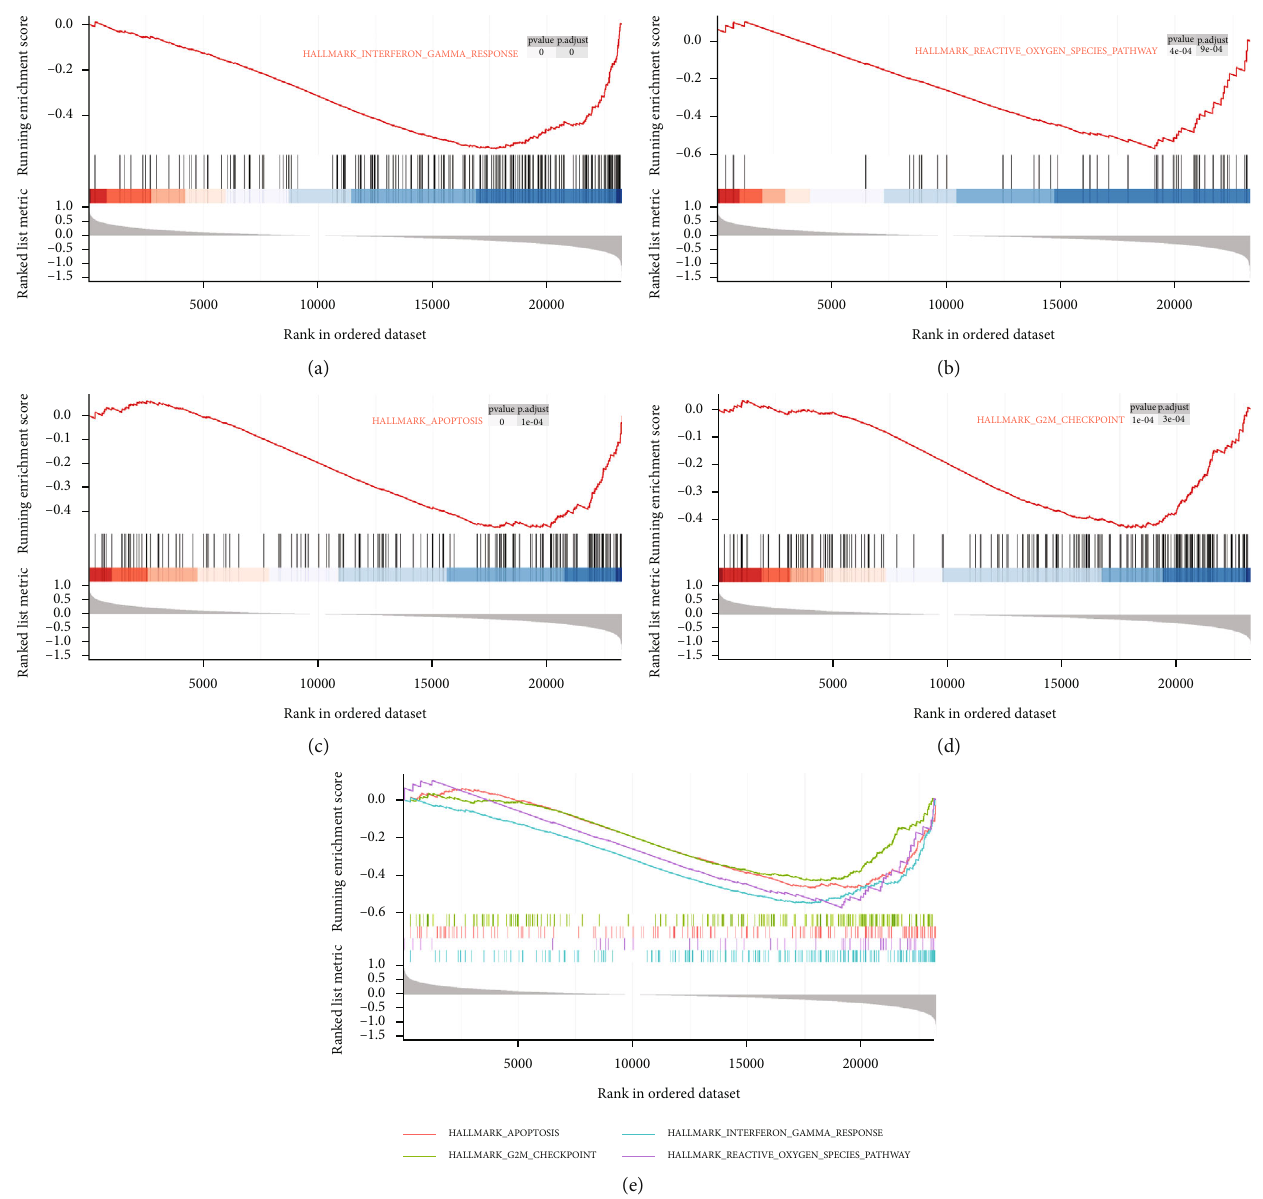
Figure 7: Low GPX8 expression is signi fi cantly correlated with (a) interferon gamma response, (b) reactive oxygen species pathway, (c) apoptosis, (d) G2/M checkpoints, and (e) merged four